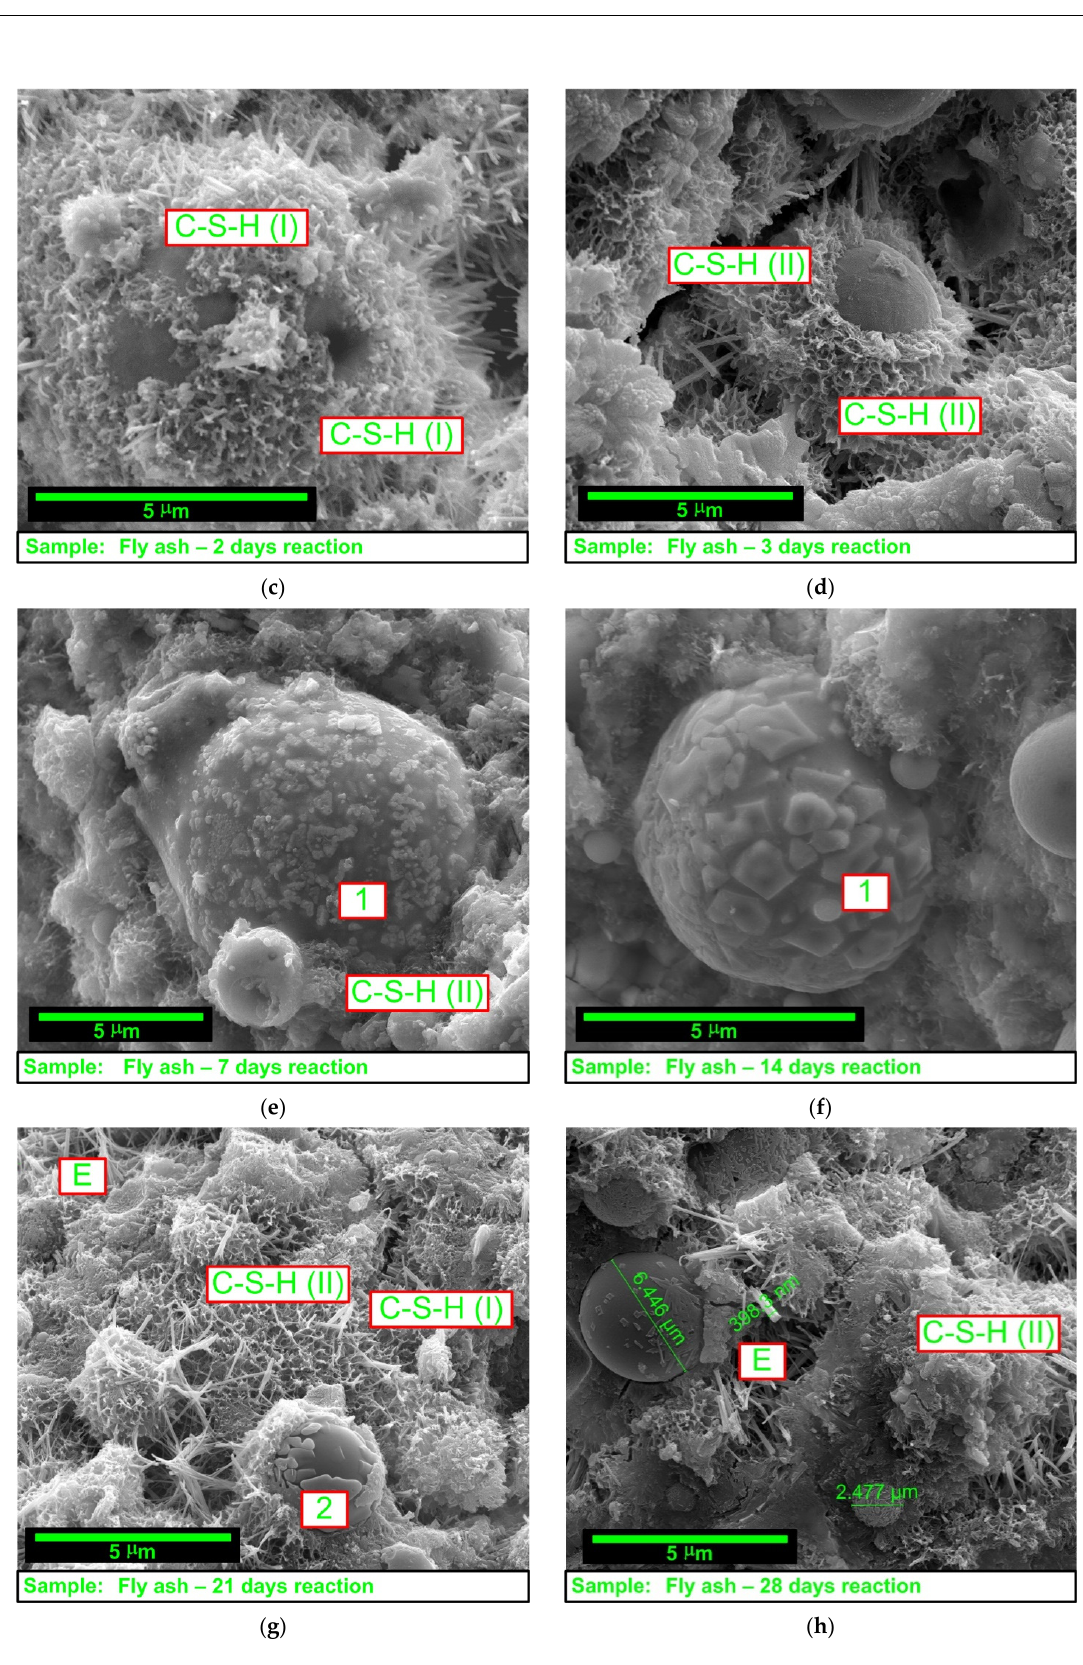
Figure 2. Fly ash grain reaction stages between 0.5 and 28 days of curing process: 1—glass matrix of FA grain, 2—exterior glass hull of FA grain; description in the